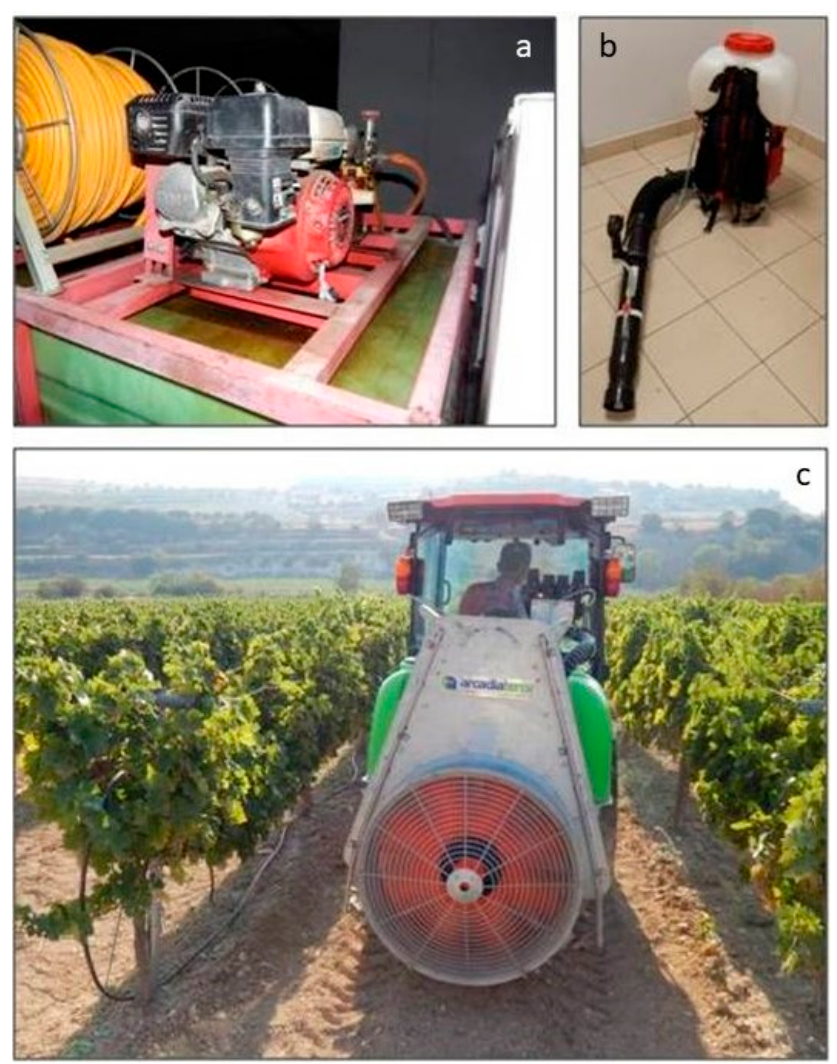
Figure 1. Sprayers tested: ( a ) HVS with a spray gun ( b ) LVS (Motorized knapsack sprayer) ( c ) OS (Axial fan orchard sprayer).